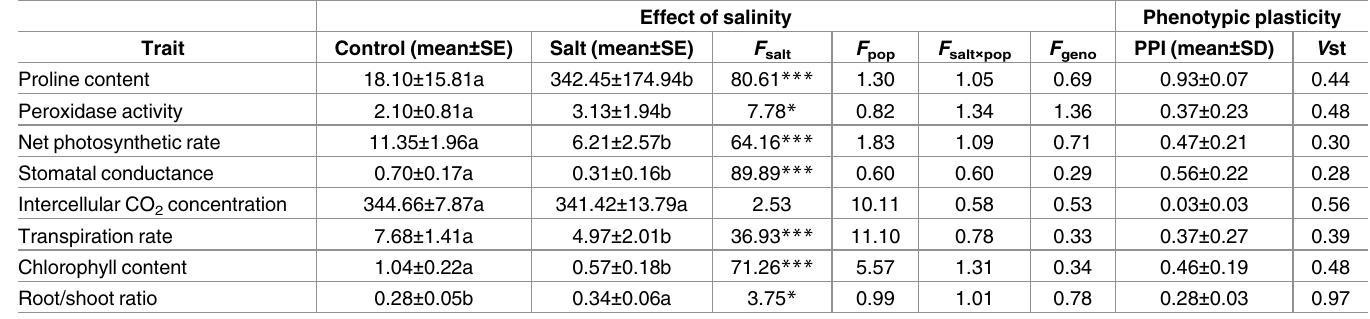
Table 3. Mean ± standard error (SE) of each physiological trait under the control and salt treatment and the mean ± SD and differentiation coeffi- cient ( V st) of the phenotypic plasticity index (PPI) for each physiological trait of Solidago canadensis . Different small letters on the same line indicate that the difference betweenthe control and salt treatment was significant.The results of two-way ANOVA and the population differentiationcoefficient are